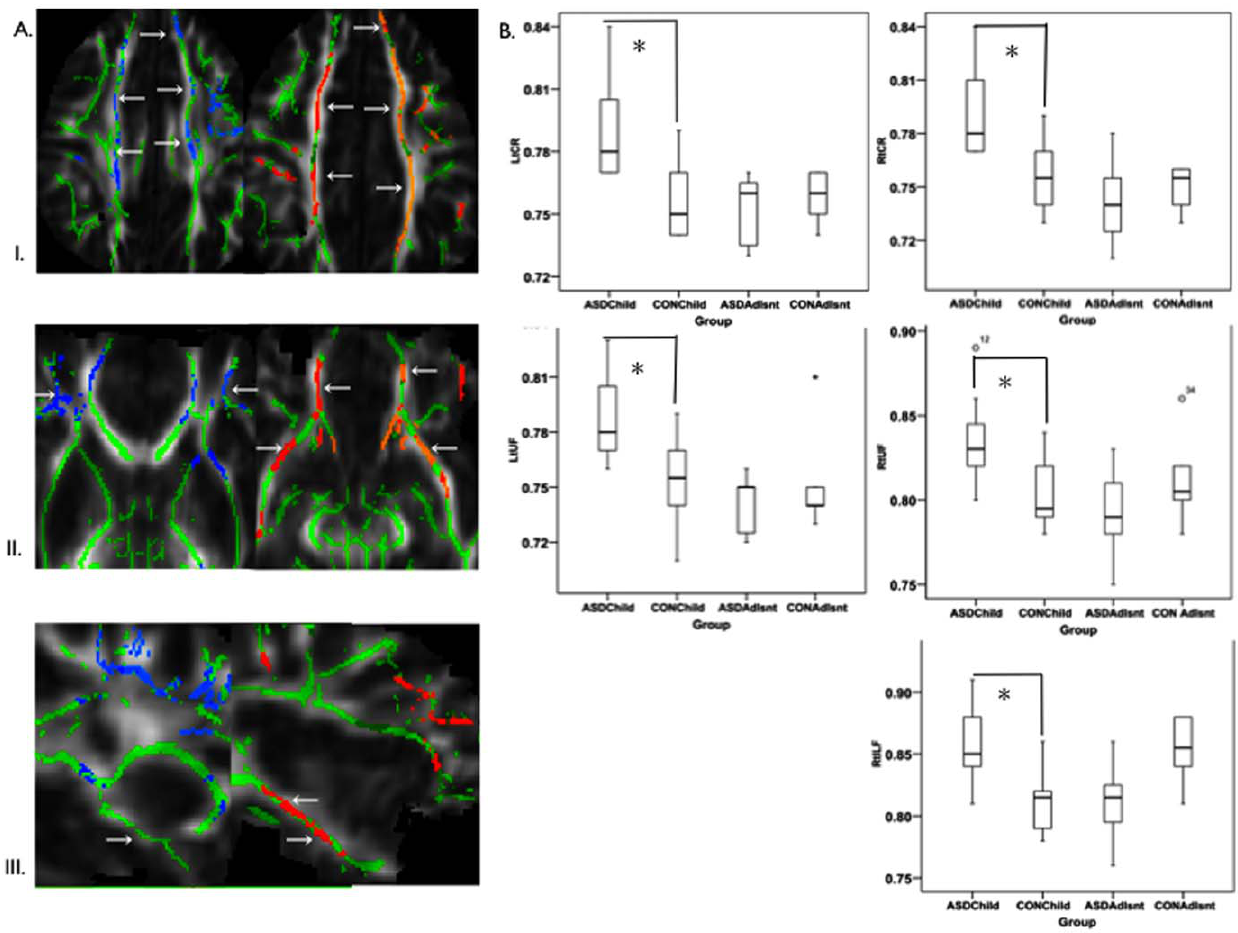
Figure 2. Voxel and tract-based increases in white matter diffusivity in children with autism spectrum disorders (ASD). (2A.) Results of voxel based comparisons depicting white matter clusters featuring increased mean and radial diffusivity in children with ASD. Left: White matter clusters featuring increased mean diffusivity (MD) in ASD are presented in blue. Right: White matter clusters featuring increased radial diffusivity in ASD are presented in red. Rows: (I) left (Lt) and right (Rt) Superior Corona Radiata (CR); (II) Lt and Rt Uncinate Fasciculus (UF); and (III) Rt Inferior Longitudinal Fasciculus (ILF). Note, no difference in MD (image III, left column) was found for Rt ILF in ASD, on TBSS analysis. (2B.) Boxplots depicting MD values for tract-based comparisons corresponding to white matter clusters depicted in 2A. Results for ASD and control (CON) children (Child) and adolescents (Adlsnt) are presented. Significant increases for MD in ASD children were found in Lt and Rt CR (t 1,19 =3.1, 3.6, p=.006, 002, respectively), Lt and Rt UF (t 1,19 =3.1, 3.1, p=.006,.006, respectively), and Rt ILF (t 1,19 =3.3, p=.004). Diffusivity units: mm2/s 6 10 2 3. *Significant following multiple comparison correction.